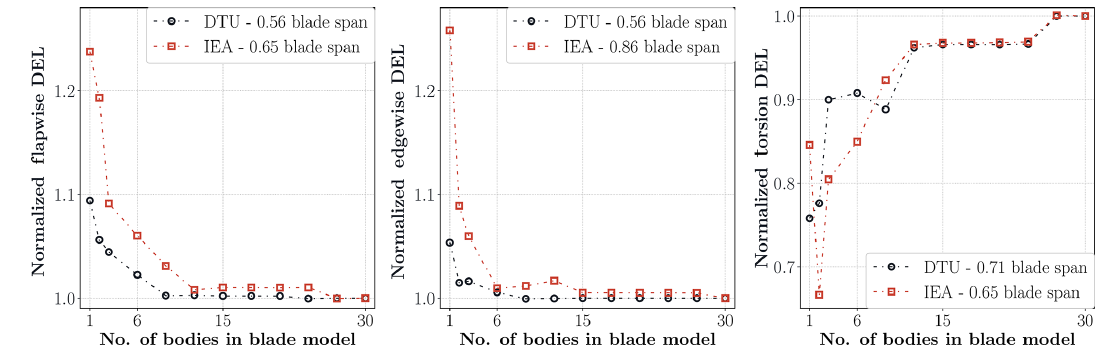
Figure 7. Normalized flapwise, edgewise and torsion moment DEL ratio variations with respect to the number of blade model sub-bodies at blade stations where the maximum deviations between linear and nonlinear cases occur.